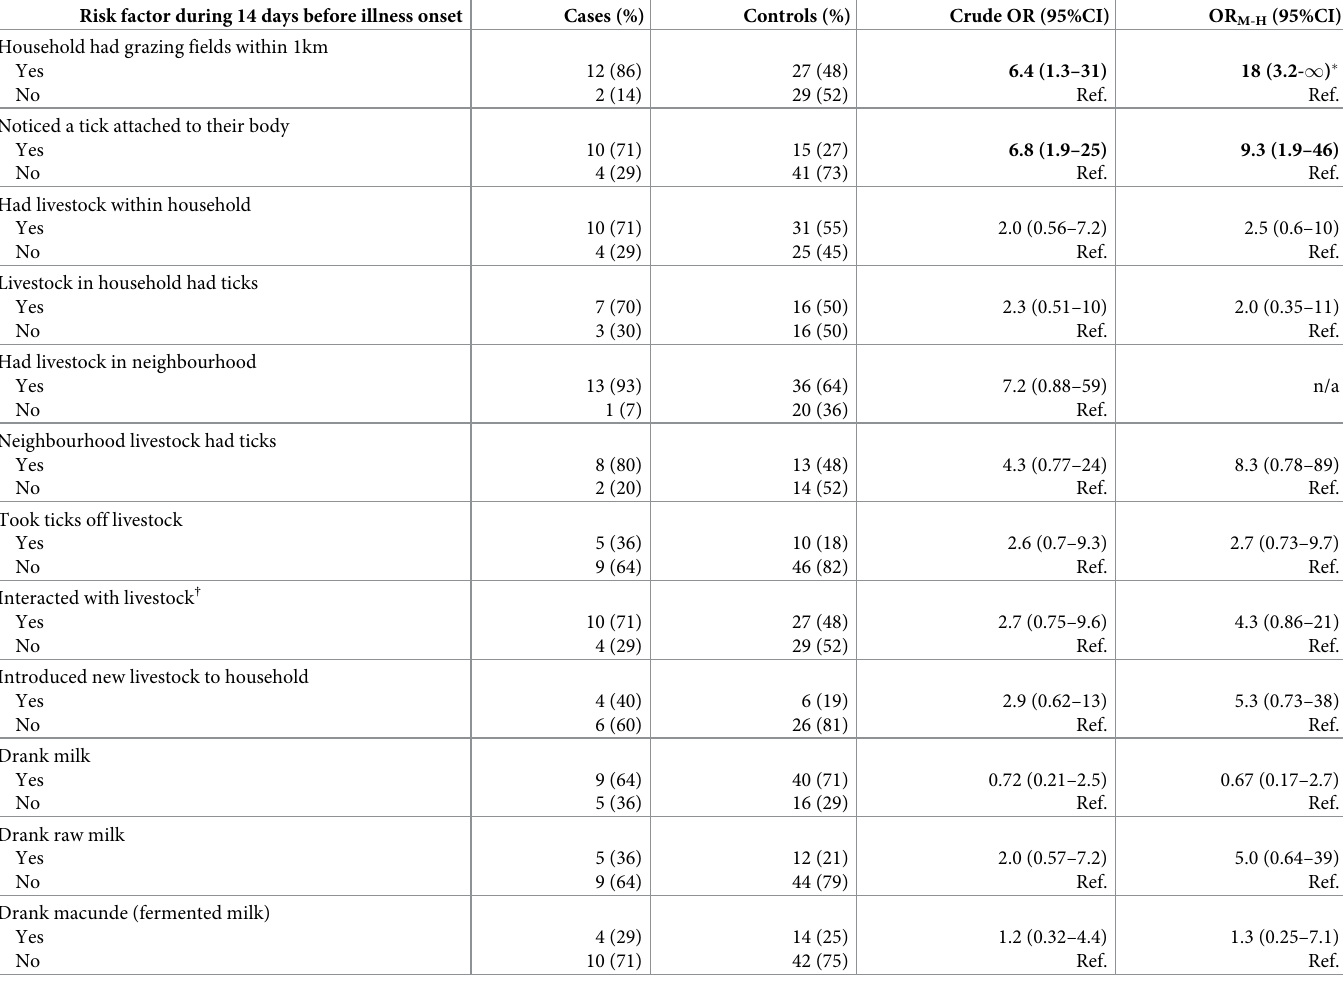
Table 2. Association between risk factors and Crimean-Congo haemorrhagic fever infection during July 2018 to January 2019 in Western and Central Uganda. Risk factor during 14 days before illness